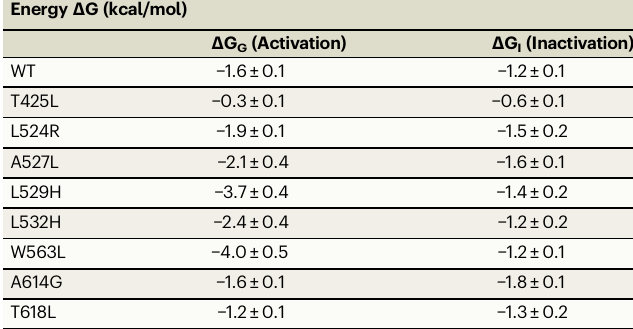
Table 2 | Free-energy of activation and inactivation evaluated for WT and all the mutant channels Energy Δ G